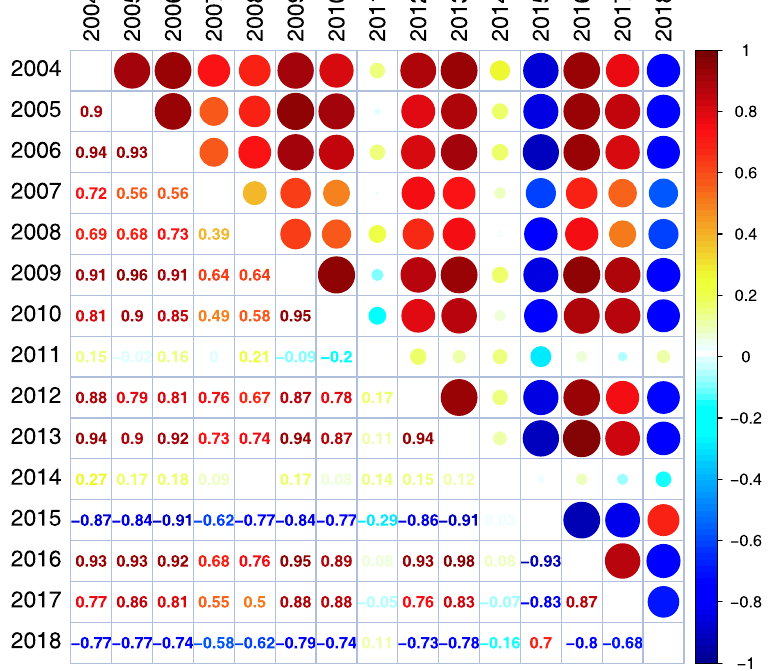
Figure 9. Pearson correlation matrix for time series of detrended groundwater levels corresponding to the winter seasons of the